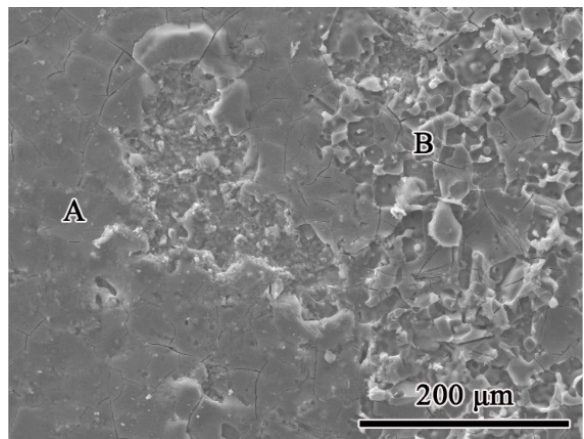
Figure 7. Surface morphology of the SiO 2 ‐ Al 2 O 3 glass composite coating after corrosion in marine environment for 100 h at 650 °C.